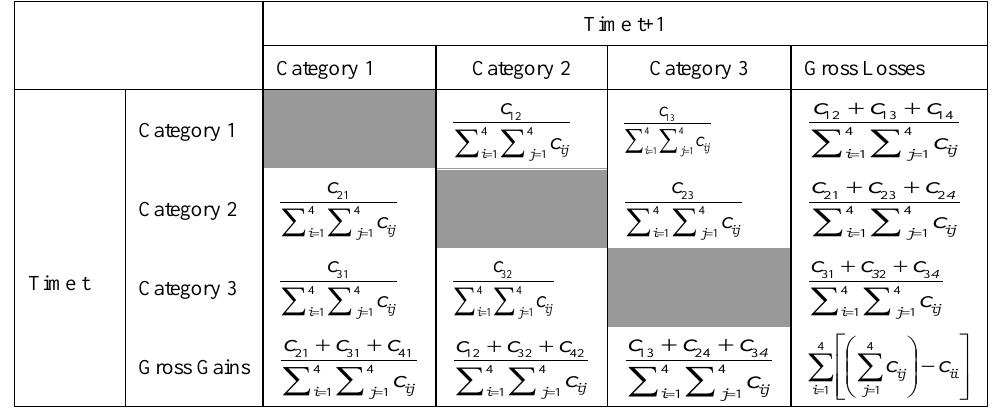
Table 2. The Flow Matrix form (Runfola, Pontius, 2013) (2) Based on Flow Matrix to calculate urban land